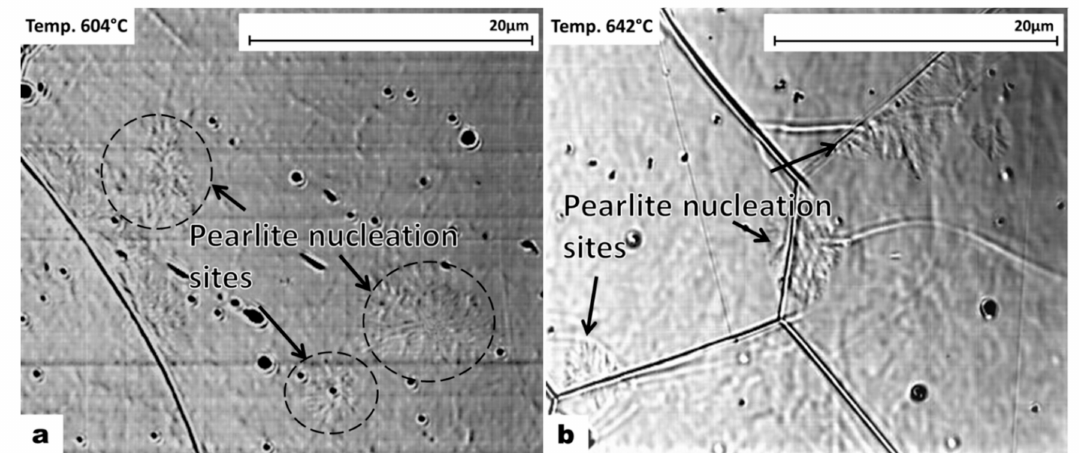
Figure 7. CSLM micrographs showing pearlite nucleation sites at di ff erent cooling rates. ( a ) 6 ◦ C / s. ( b ) 1 ◦ C / s.